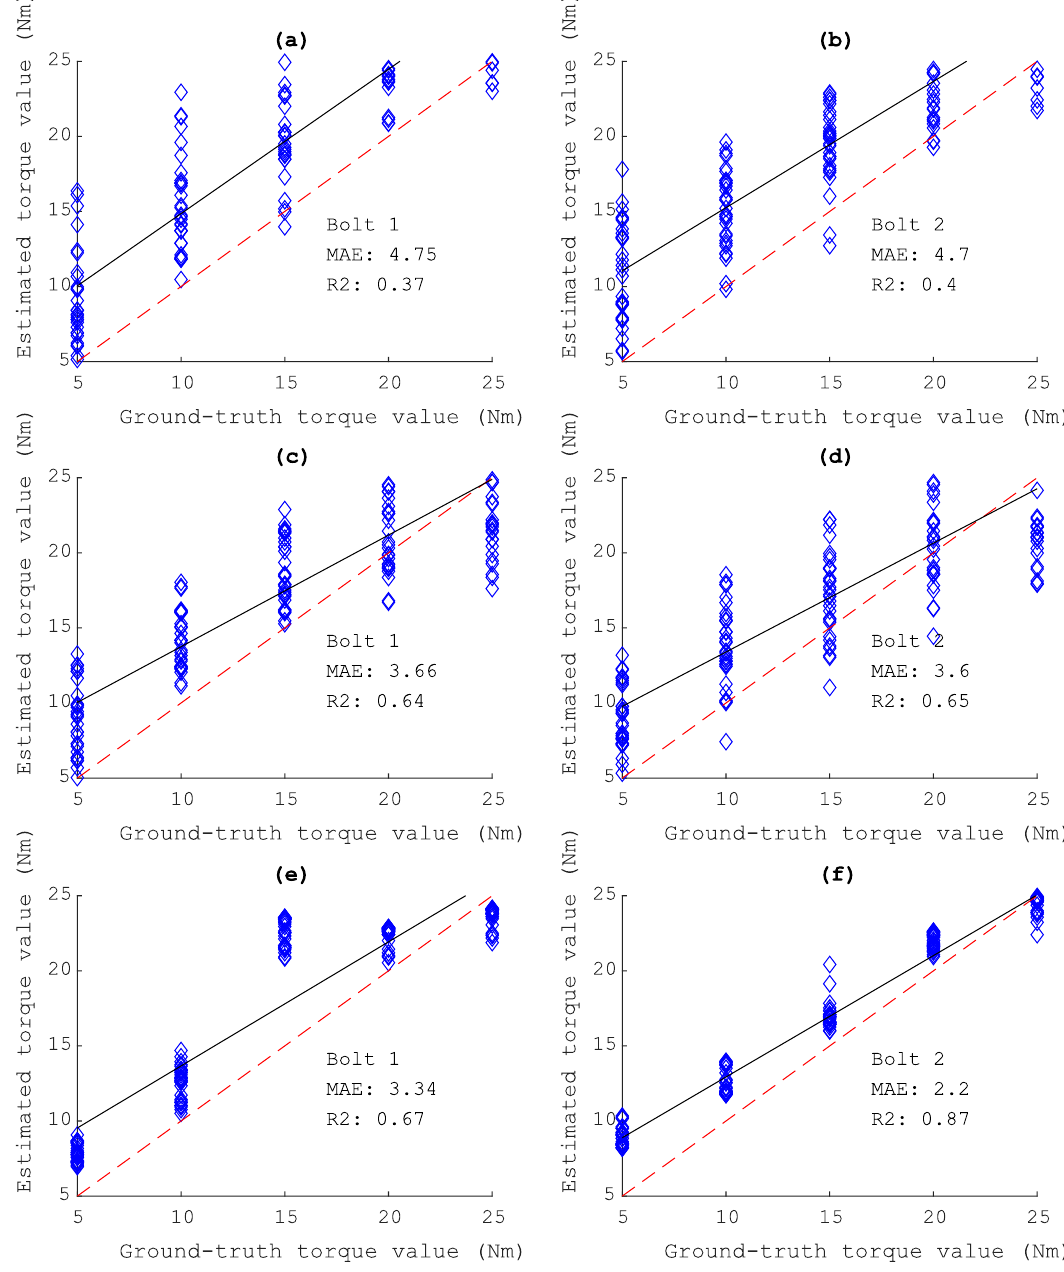
Figure 18. Estimated looseness using trained models. ( a , b ) Predicted results from the trained model using D1 data set on bolt 1 and bolt 2. ( c , d ) and ( e , f ) using D2, D4 data set, respectively. Table 3. Torque value prediction accuracy of the different data